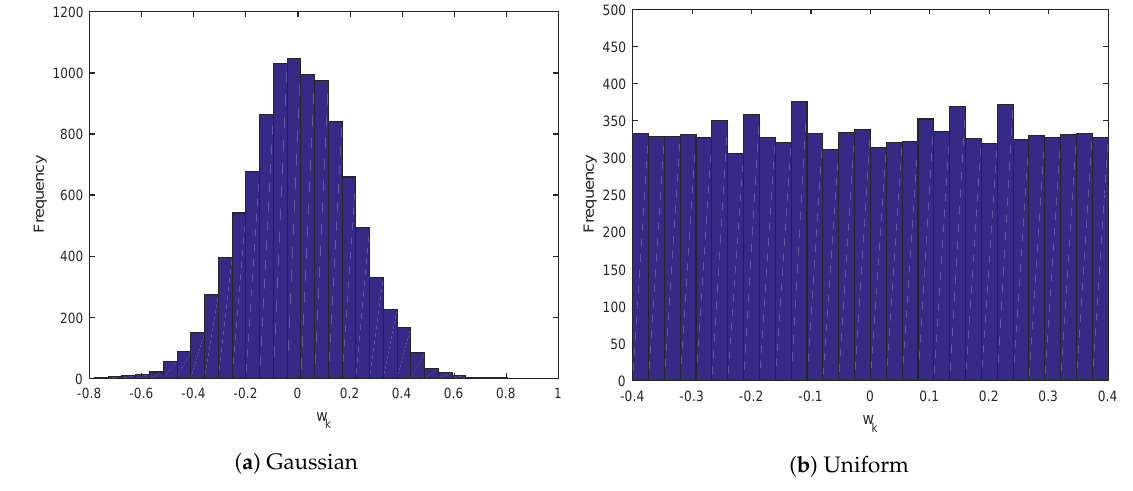
Figure 5. Uncertainty